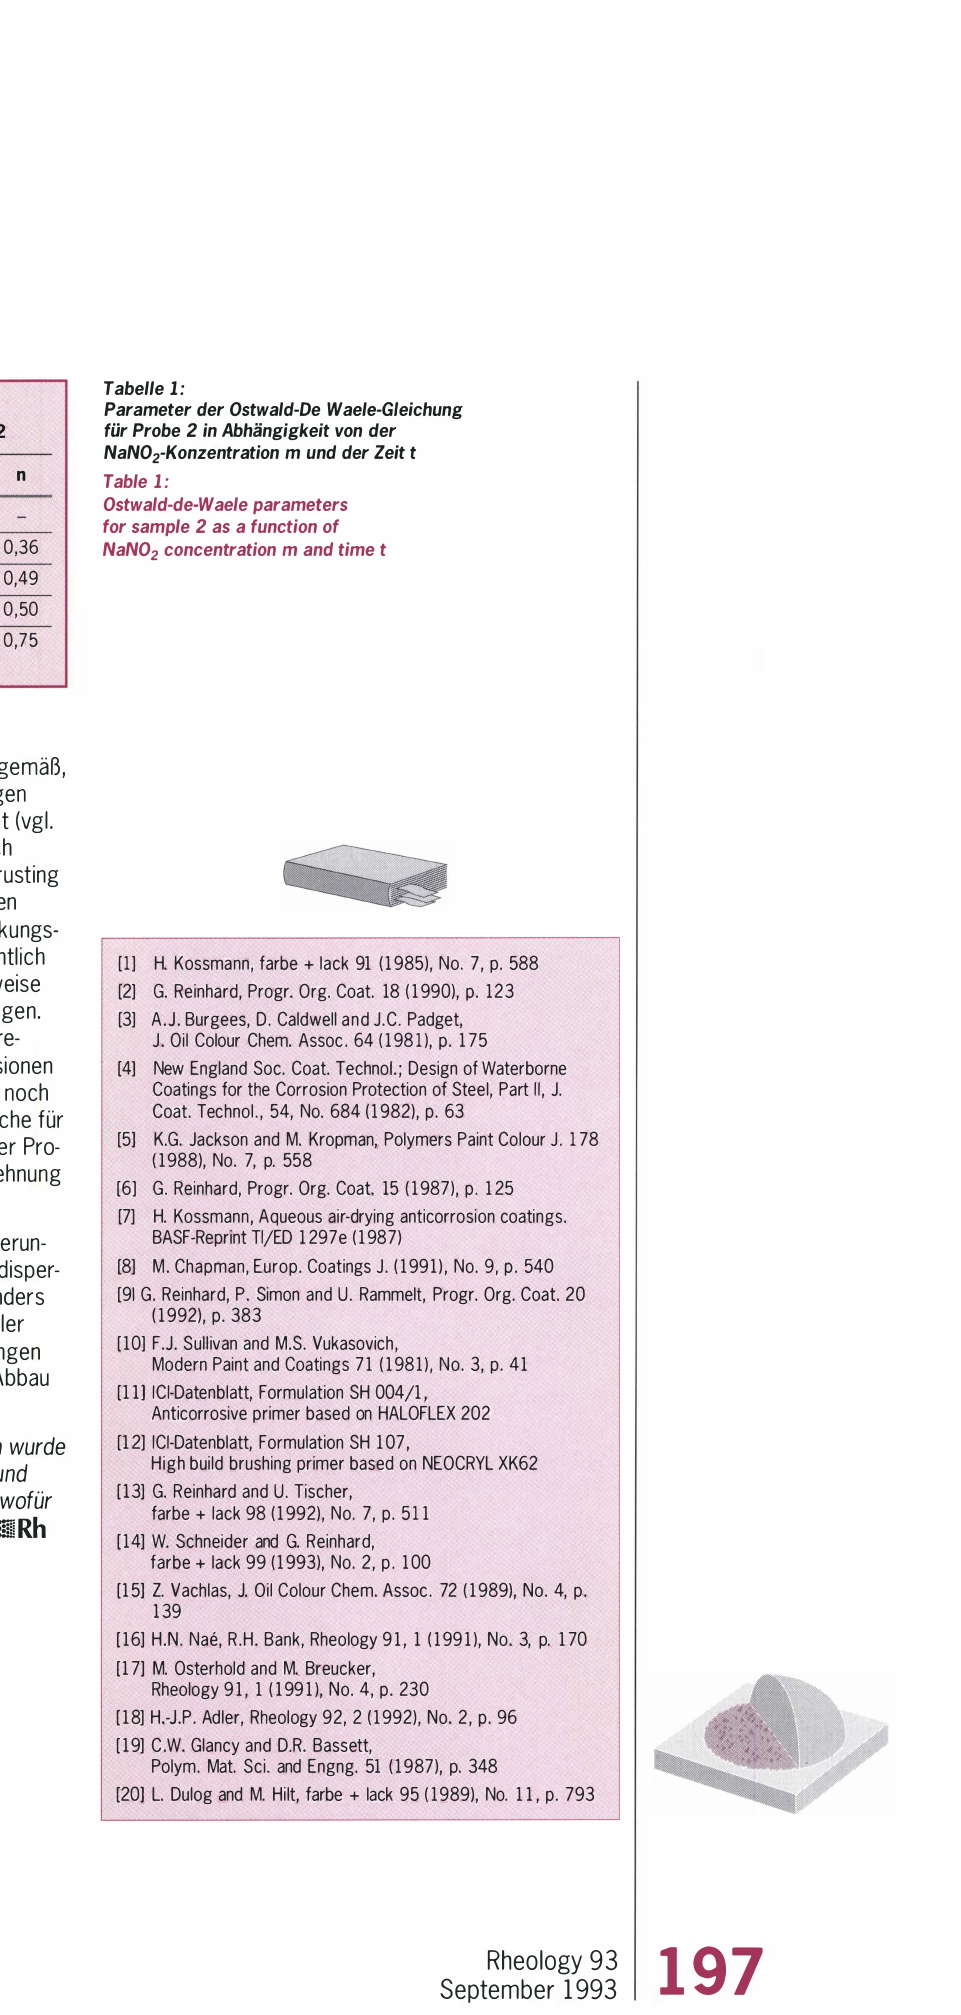
Table 1: Ostwald-de-Waele parameters for sample 2 as a function of NaN02 concentration m and time